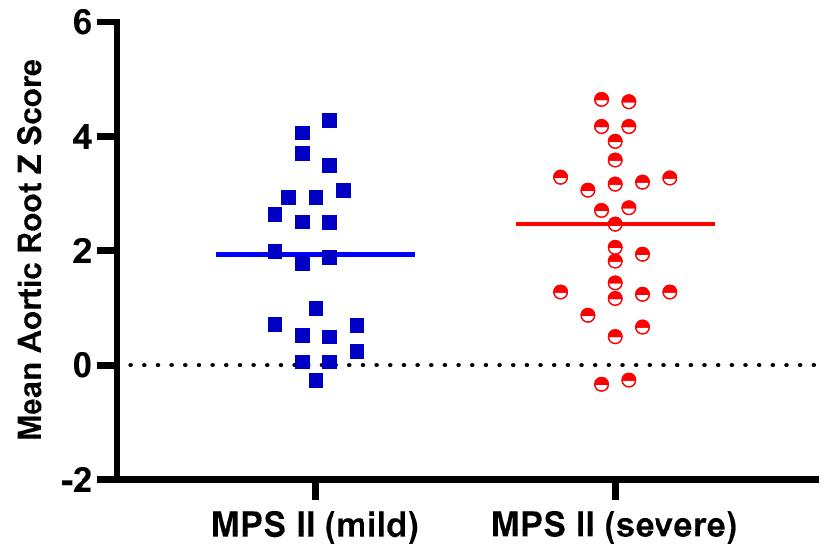
Figure 4. Aortic root diameter z score in the patients with the mild and severe forms of MPS II ( p = 0.287).